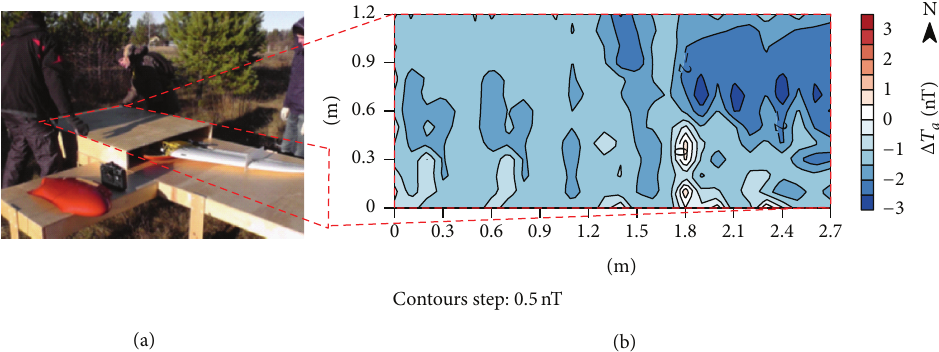
Figure 2: Special stand for experiments: (a) mount UAV; (b) background magnetic field Δ𝑇 𝑎 (top level without